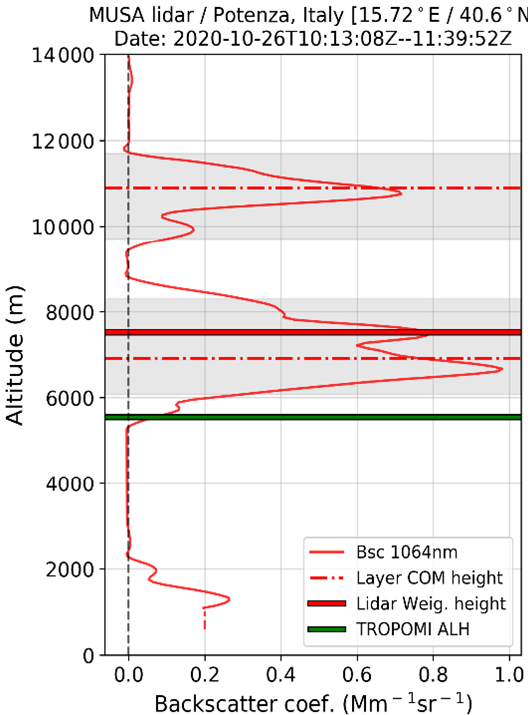
Figure 14. The same as Fig. 5 but for the MUSA lidar